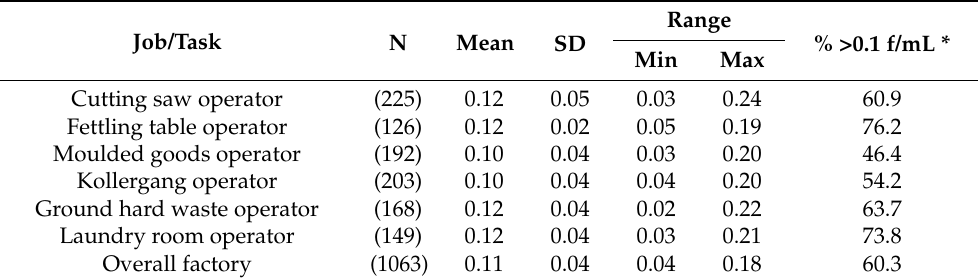
Table 2. Mean airborne personal chrysotile asbestos fibre concentrations (f/mL) for various opera- tions/tasks in the Harare chrysotile cement manufacturing factory.